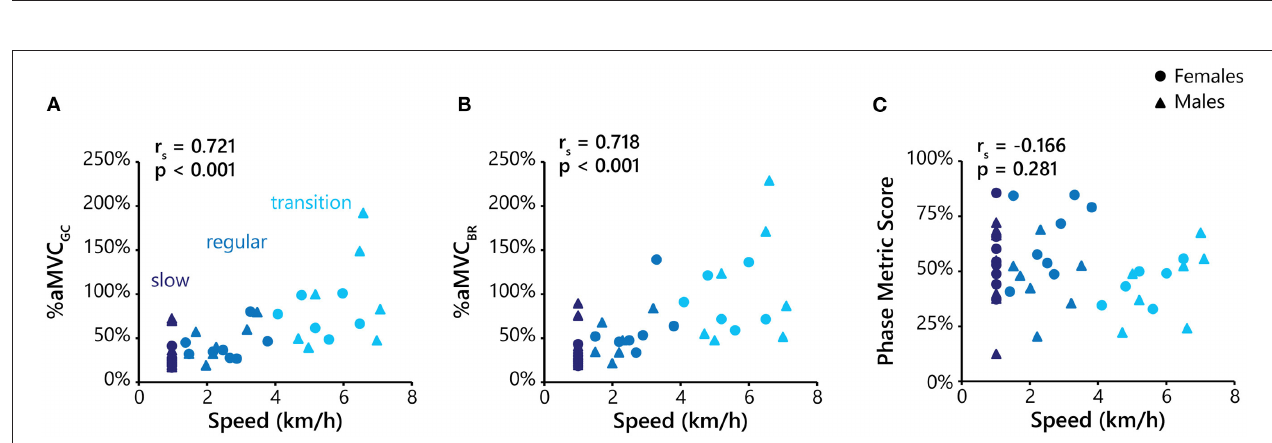
FIGURE 4 | (A) An example of averaged pelvic floor muscle (PFM) and right/left gluteus maximus (R/LGM) electromyography activity for one participant during regular walking, normalized to their gait cycle (0% represents right heel strike). Periods of the gait cycle where both muscles are in phase (i.e., both are bursting or neither are bursting) are highlighted in light gray, and periods of the gait cycle where the PFM and L/RGM are out of phase (i.e., only one is bursting) are highlighted in dark gray. (B) Results from the phase metric analysis. Individual subject data of female participants is represented by the purple circles, and that of male participants by the green triangles. Only data from transition walking and jogging (dark gray) were used for statistical analysis to compare the effect of gait modality, at a matched speed, on phase metric score.